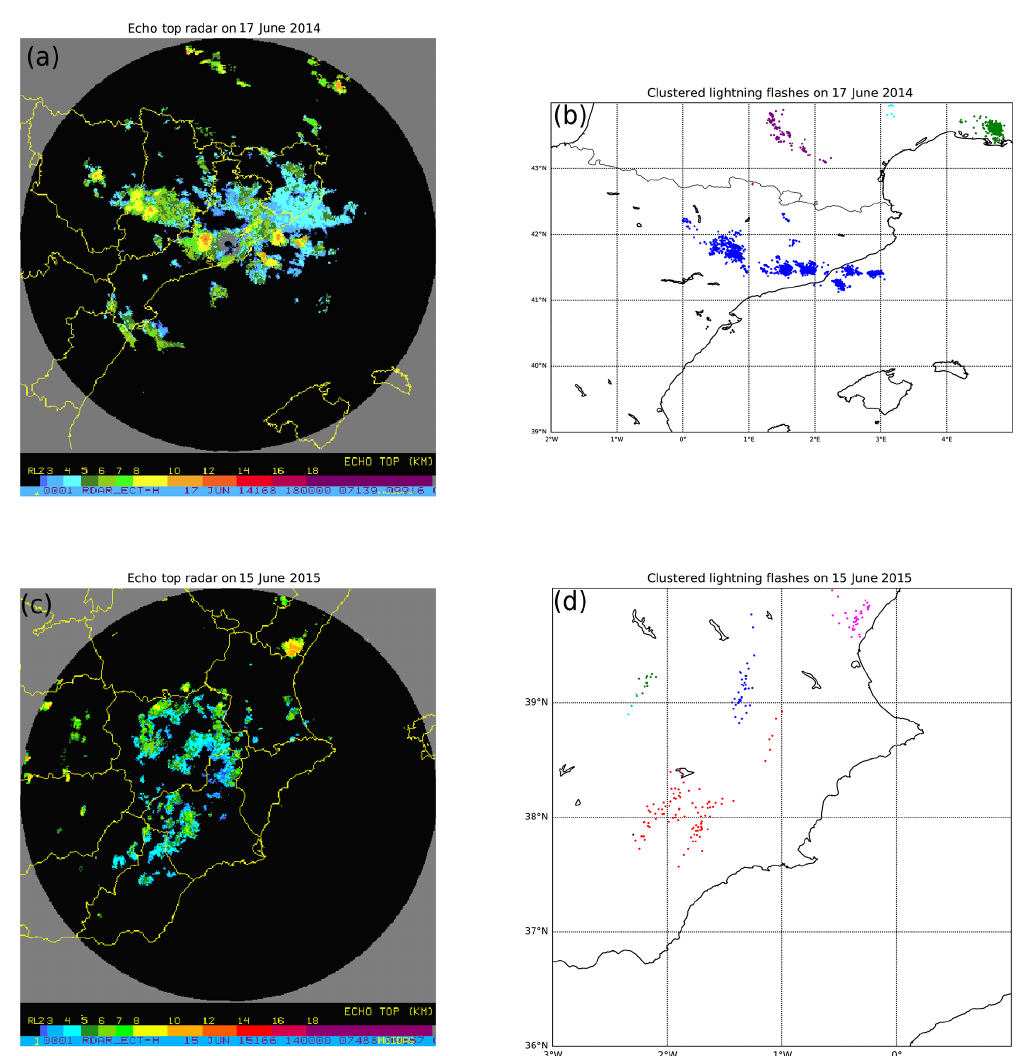
Figure 13. Echo top radar images provided by AEMET showing the maximum height (in kilometers) of precipitable particle echoes at 12dB and 15min around one fire-ignited lightning on 17 June 2014 at 18:00UTC (a) and on 15 June 2015 at 14:15UTC (c) . Lightning flashes reported by ENTLN on 15 June 2014 between 17:45 and 18:15UTC (b) and on 15 June 2015 between 14:00 and 14:30UTC (d) . Different colors indicate different lightning clusters or thunderstorms using ST-DBSCAN, with the spatial and temporal parameters of 0.12 ◦ and 15min,